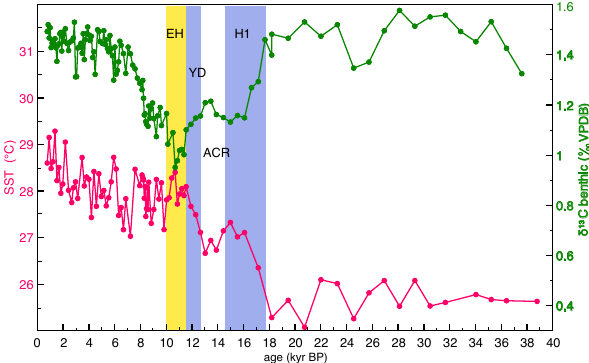
Fig. 5. Comparison of δ 13 C benthic record in ‰ VPDB (green) and SST record based on shell Mg/Ca ratios of planktic foraminifera ( ◦ C; pink) of GeoB12615-4. EH, YD, ACR and H1 indicate early Holocene, Younger Dryas, Antarctic Cold Reversal and Heinrich event 1,